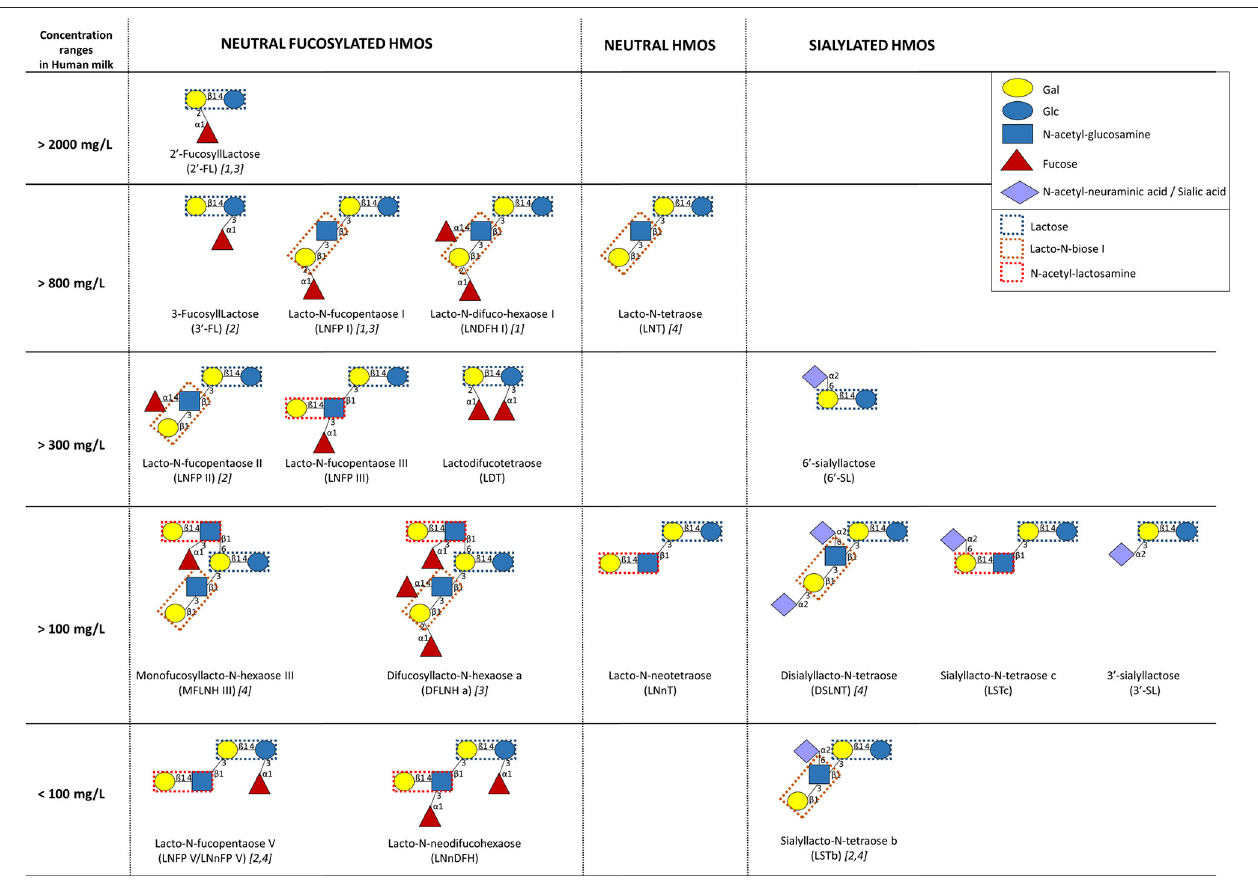
FIGURE 2 | Human milk concentrations of the top human milk oligosaccharides (HMOs) over the first 4 months of lactation ( n = 290 European healthy mothers), adapted from (67) and (64). [1, 2, 3, and/or 4] indicate the highest HMO concentration in milk of secretor [ α 1-2-fucosyltransferase FUT2 secretor (Se) gene] and Lewis [ α 1-3/4-fucosyltransferase FUT3; Lewis (Le) gene] groups (1, Se + Le + ; 2, Se–Le + ; 3, Se + Le–; 4,